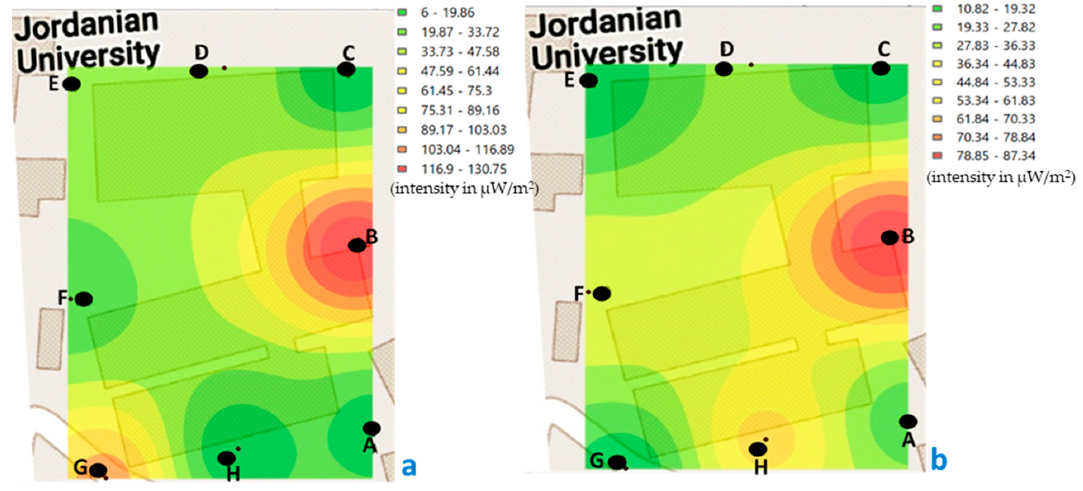
Figure 7. Georeferenced map with the levels of exposure recorded in building C (classrooms and laboratory, points A–H), in the morning. ( a ) weekend and ( b ) during the week ( µ W / m 2 ).